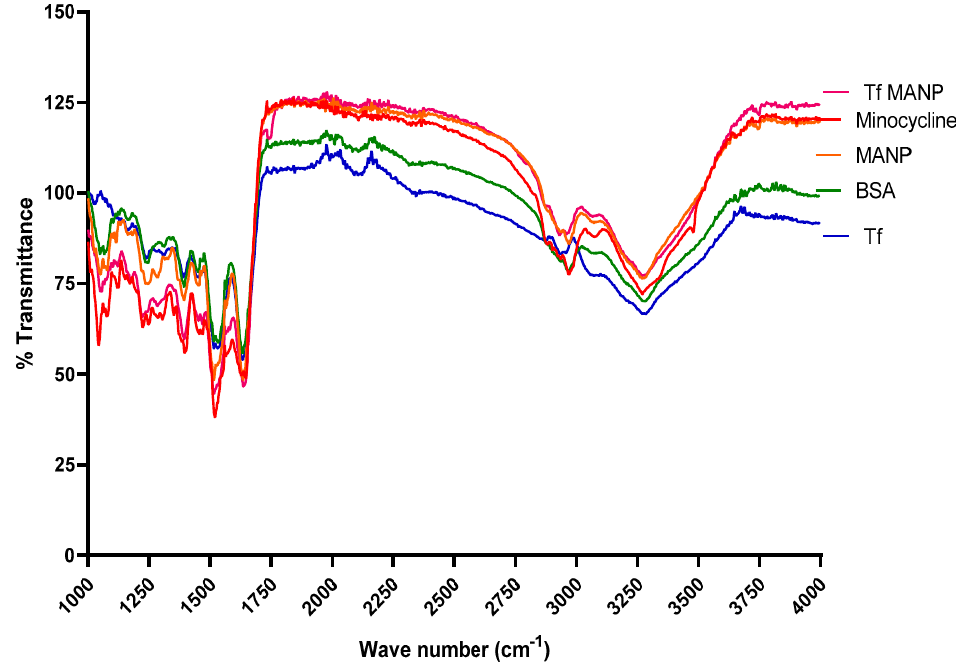
Brain Sci. 2023 , 13 , 402 Figure 3. FTIR spectra of BSA; Minocycline; Transferrin; MANP; and tfMANP. Figure 3. FTIR spectra of BSA; Minocycline; Transferrin; MANP; and tfMANP.